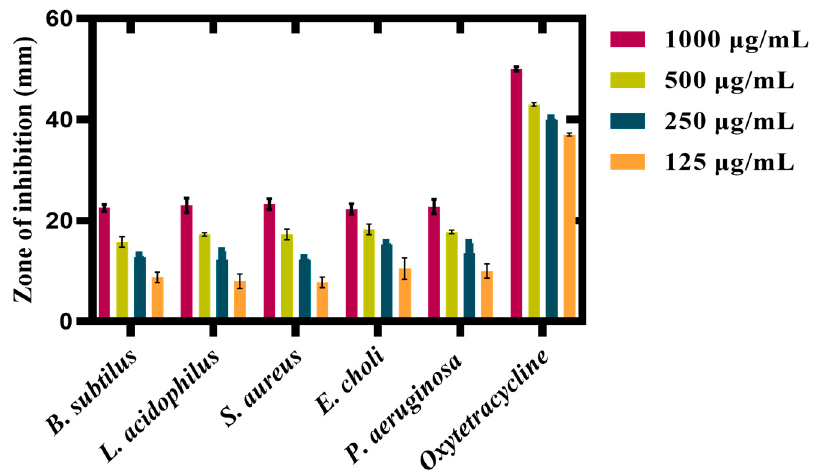
Figure 10. Antibacterial potential of mediated Ag 2 ONPs. Table 3. ZOI value of different bacterial